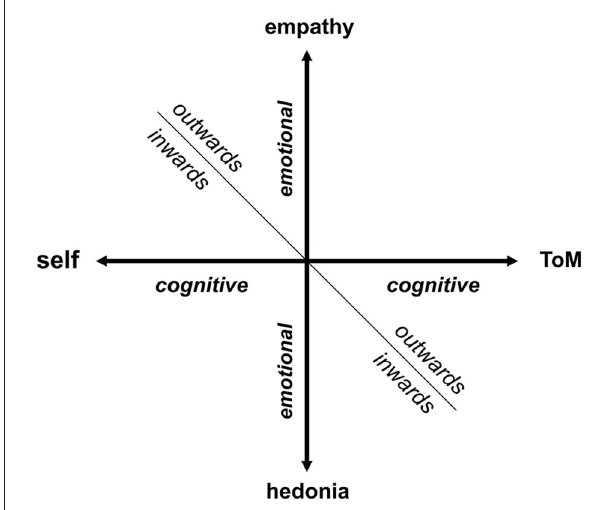
FIGURE 1 | Model of a human mind’s representation (inwards/outwards) . The horizontal axis refers to “cognitive” dimension, whereas the vertical axis refers to “emotional” dimension with stronger motivational accent. We assume that these two axes can create a mental representation of human mind, that can be focused outwards or inwards, forming four domains: self, ToM, empathy and hedonic